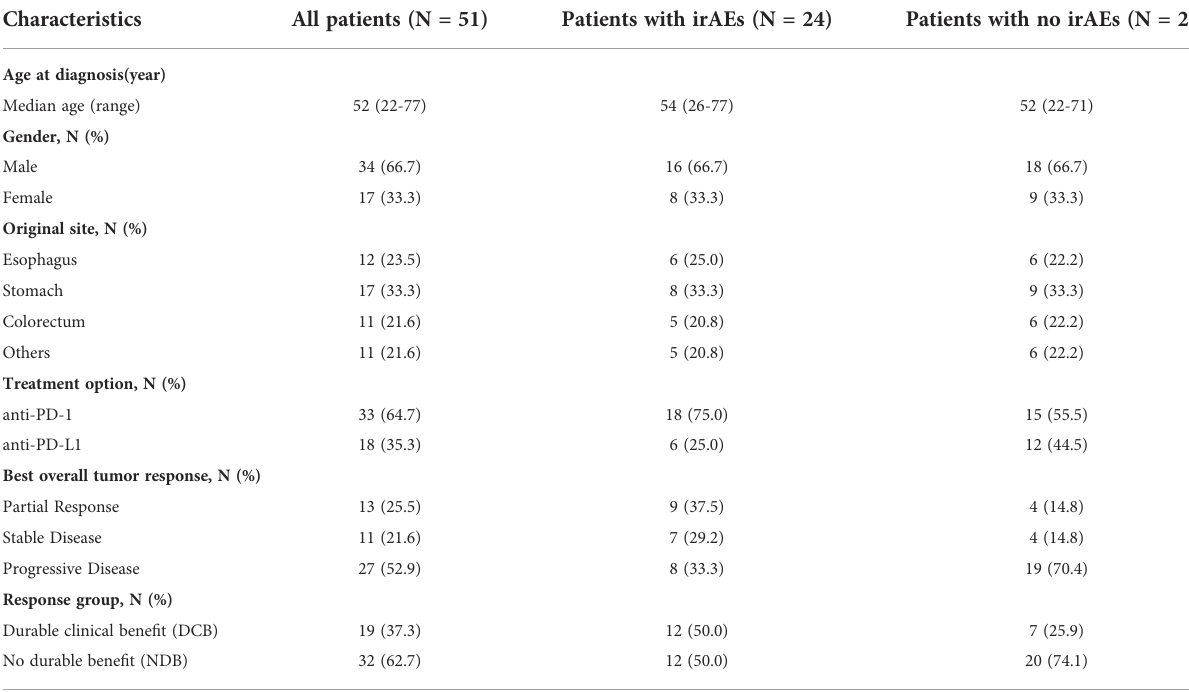
TABLE 1 Patient ’ s